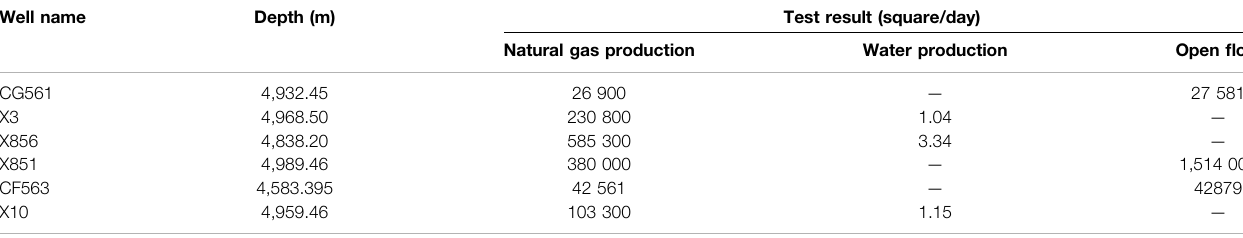
TABLE 4 | Statistics of the formation water chemical parameter results of the Xujiahe Formation in the study area. Parameter